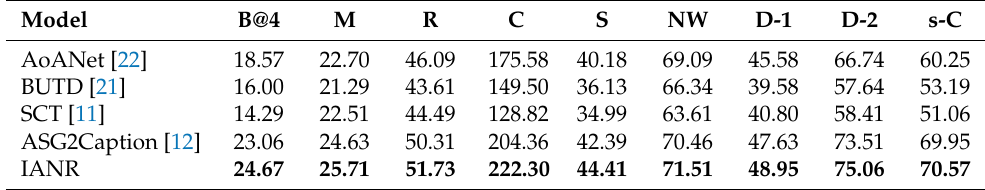
Table 5. The performance comparisons on the MSCOCO Entities dataset for controllable image captioning. All models were re-implemented and trained on the same region feature. Bold for the